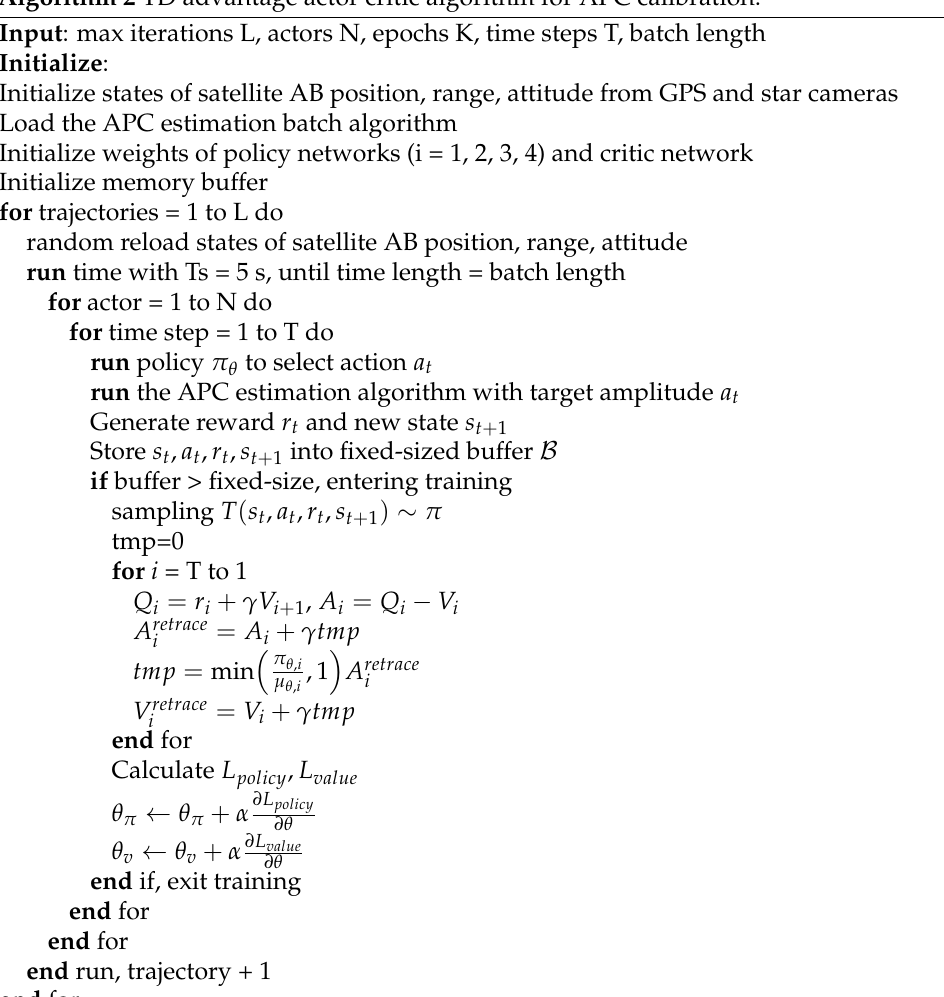
Algorithm 2 TD advantage actor critic algorithm for APC